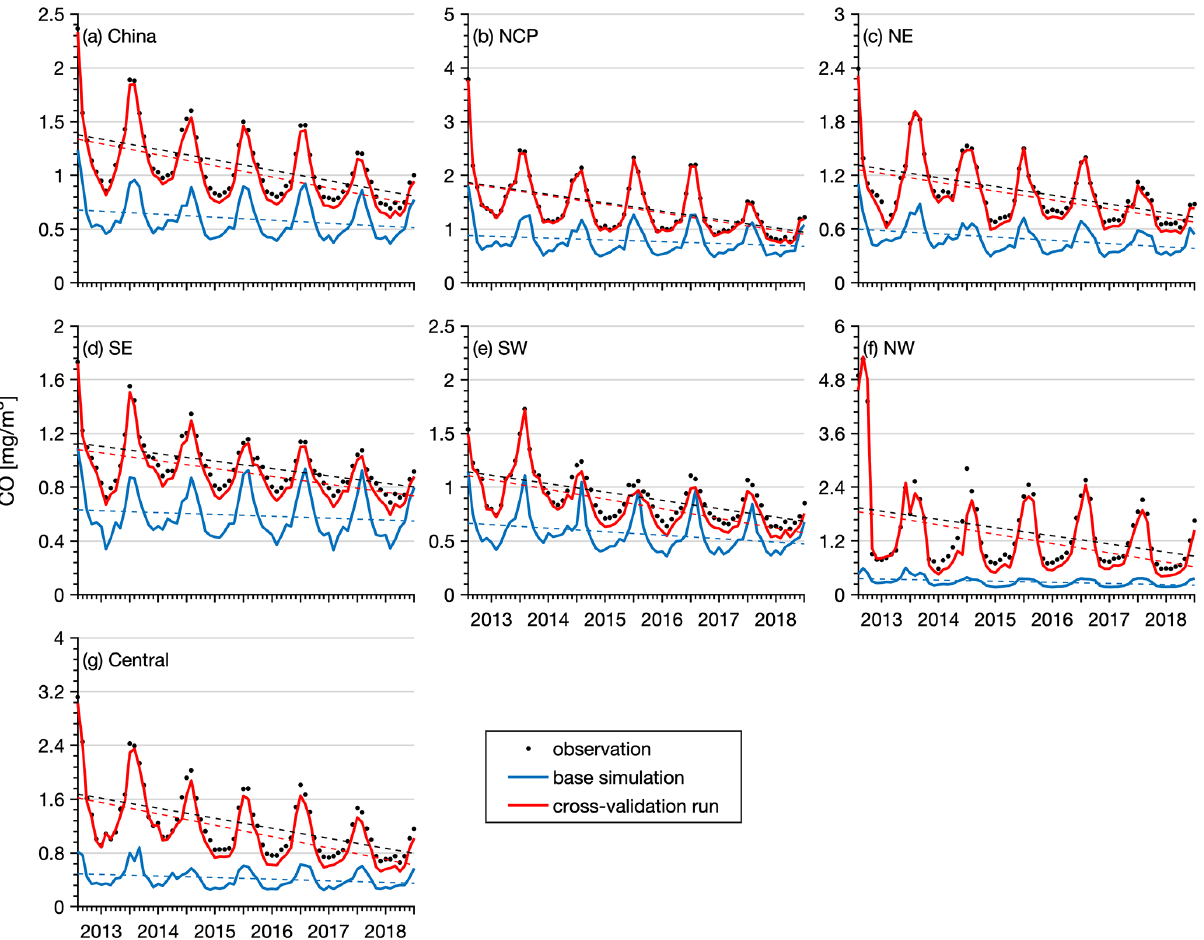
Figure 12. Same as Fig. 7 but for the NO 2